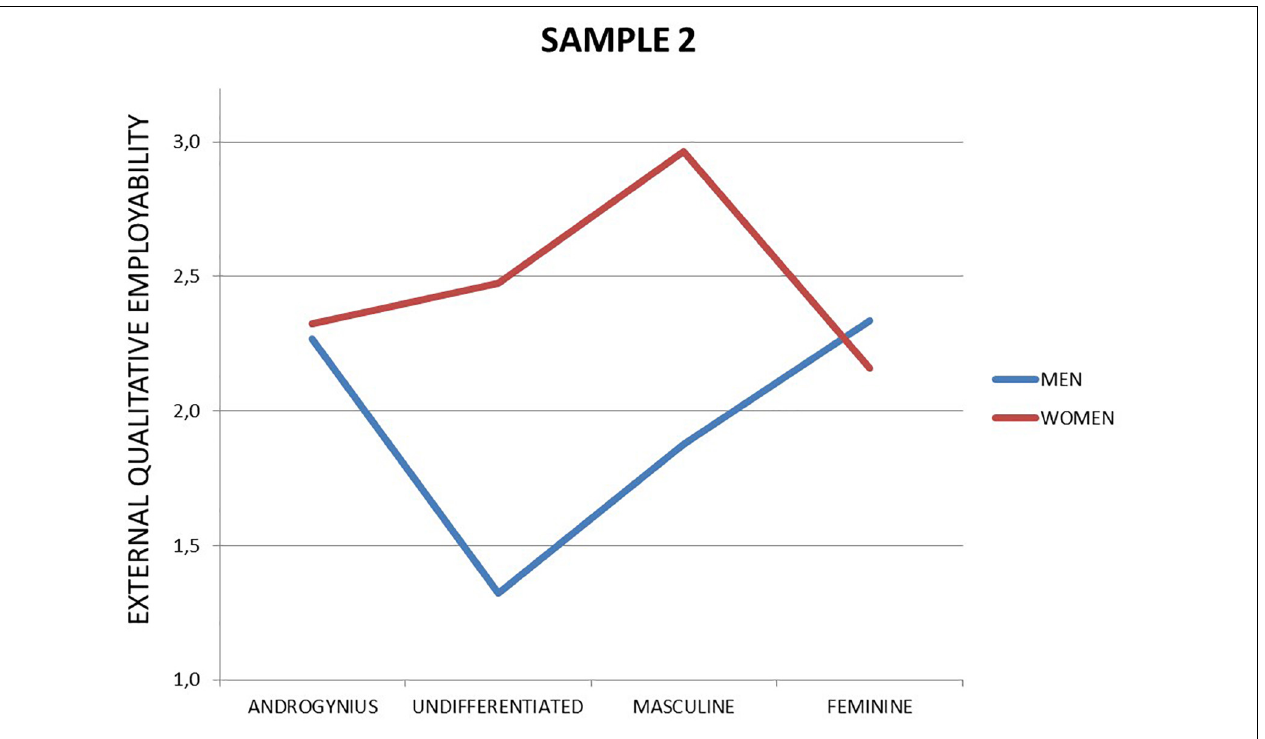
FIGURE 2 | External qualitative employability among unemployed (Sample